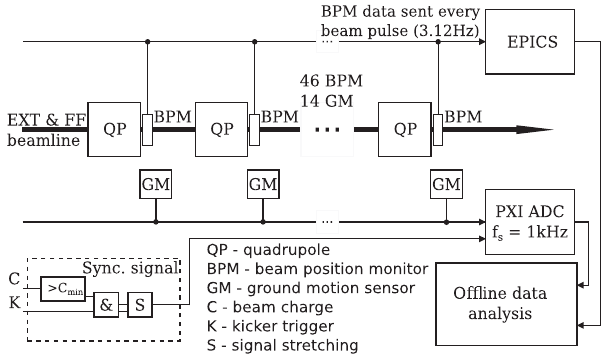
FIG. 8. Overview of the experimental setup at ATF2. The beam passes from left to right through the quadrupole magnets and